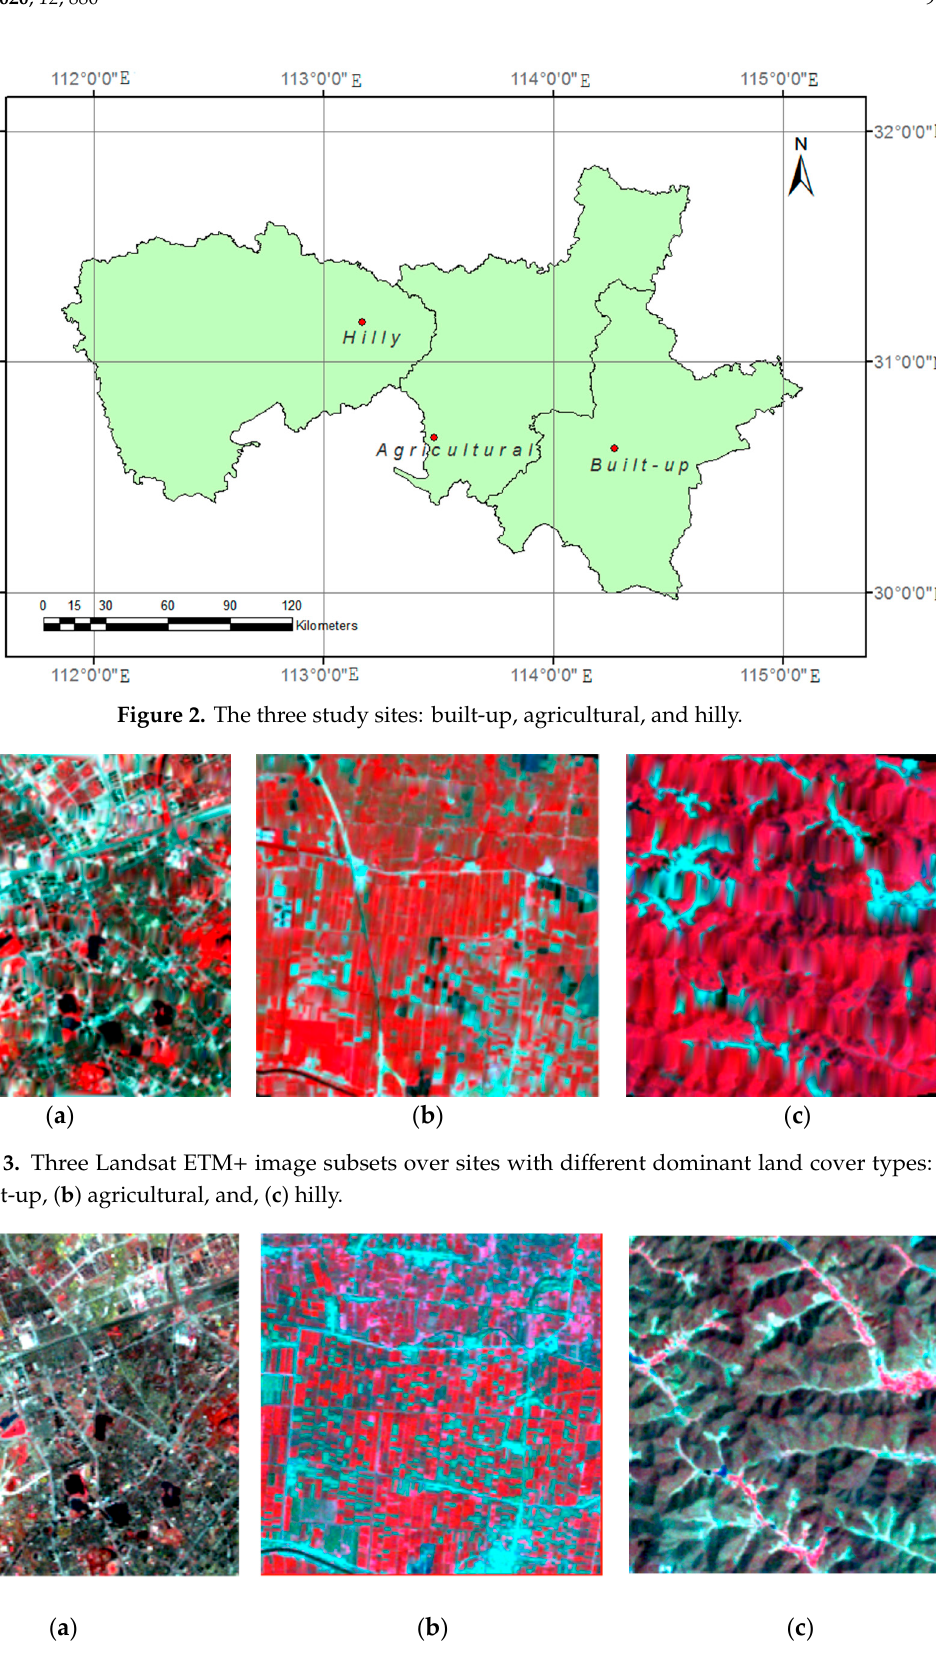
Figure 4. Three Landsat TM image subsets over the same sites as in Figure 3 with different dominant land cover types: ( a ) built ‐ up, ( b ) agricultural, and, ( c ) hilly.